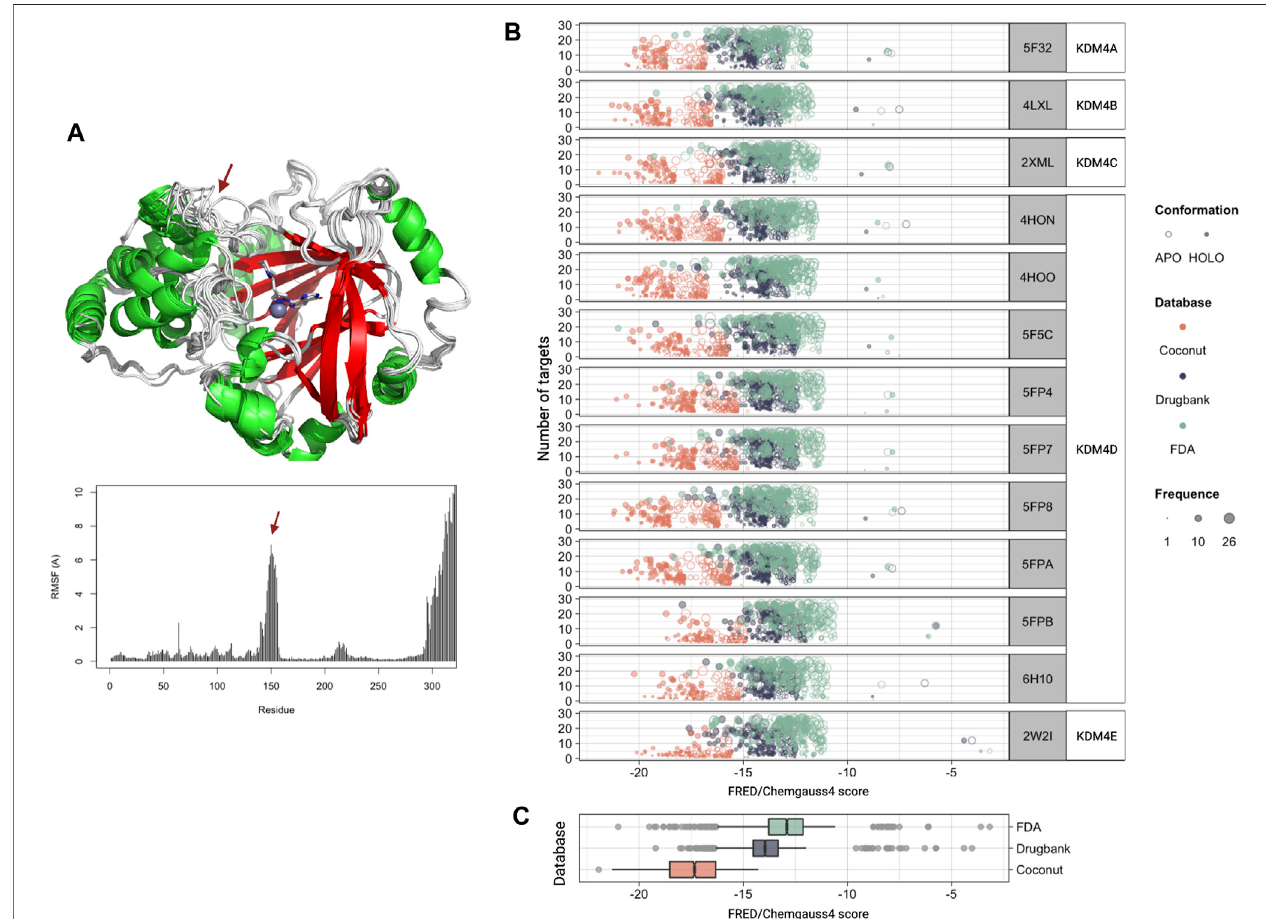
FIGURE3| MoleculardockingagainsttheKDM4subfamily. (A) Structural3Dalignment(upperpanel)androotmeansquare fl uctuation(RMSF,lowerpanel)forthe aminoacid residues of the KDM4 subfamily structures used in this work. The red arrow indicates the location of the residues with the highest RMSF. (B) FRED/ Chemgauss4 score distribution for the top 100 compounds from each database (COCONUT, FDA, and DrugBank) that were predicted to bind to each of the KDM4 family members. The fi ll indicates the enzyme system used, APO (without metal cofactors), and HOLO (with all metallic ions). Size is proportional to each compound ’ snumberoftargetsaccordingtoourdockinganalysis. (C) FRED/Chemgauss4scoredistributionforeachofthethreedatabasesevaluated.Outlierpointsare shown in gray.